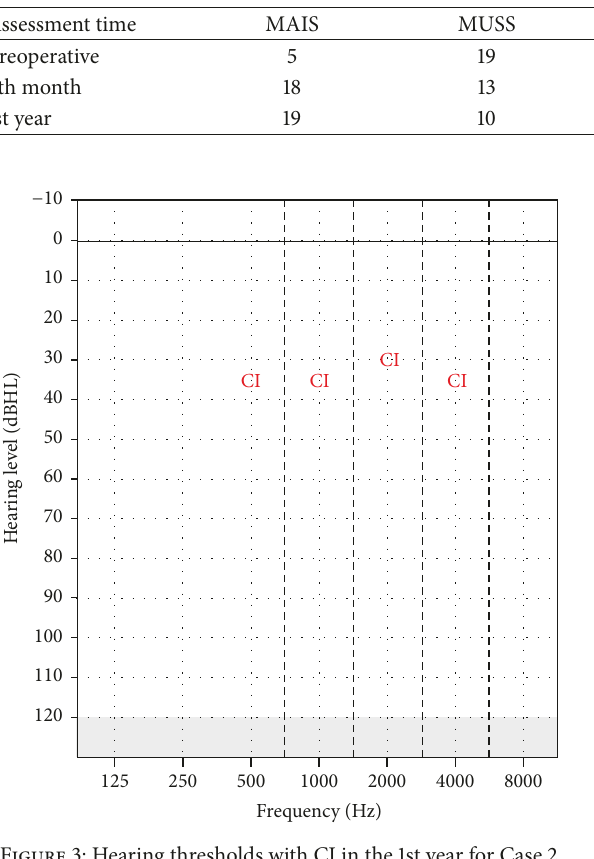
Figure 3: Hearing thresholds with CI in the 1st year for Case 2